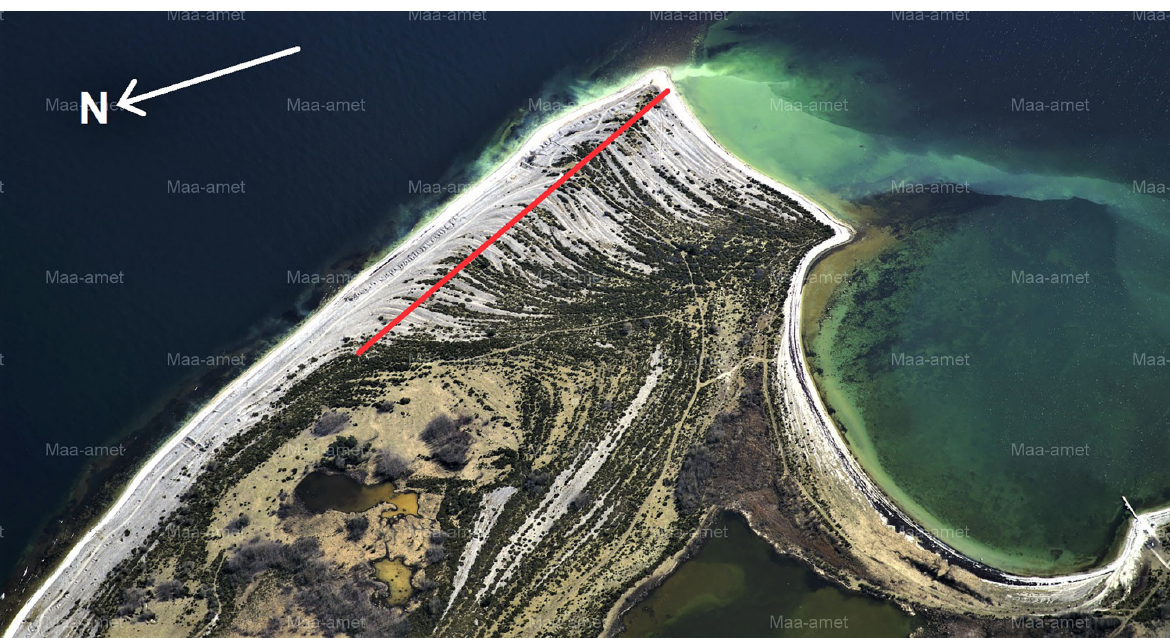
Fig. 2. An oblique (not to scale) aerial photograph of the SE tip of Osmussaar Island taken by the Estonian Land Board ( Maa-amet ) (No. 833944) on 21 April 2016. The length of the indicated transect No. 15 (including approximately 39 beach ridges) is 550 m and the age span is about 1070